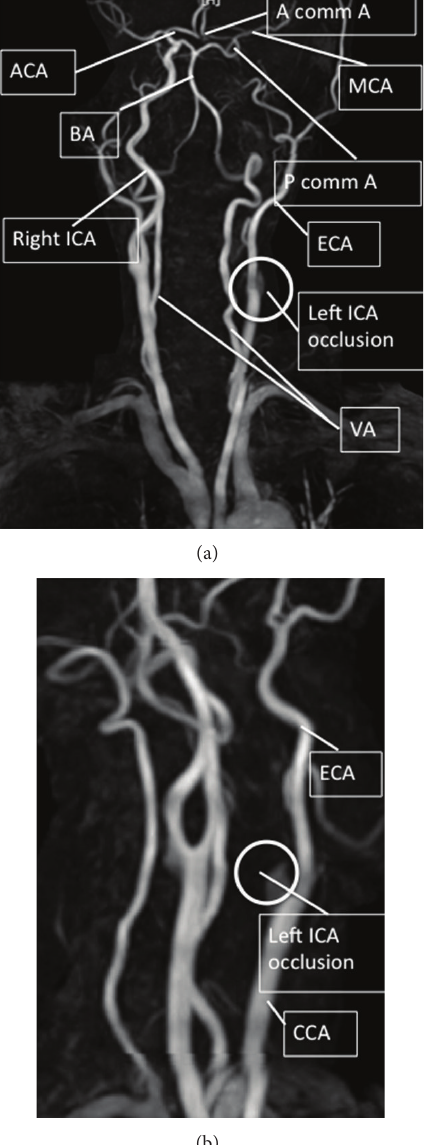
Figure 4: MRA showed an occluded carotid artery 1cm from the origin (arrows). The anterior and middle cerebral arteries were being nourished through the anterior and posterior communicating arteries. A comm A: anterior communicating artery, ACA: anterior cerebral artery, P comm A: posterior communicating artery, BA: basilar artery, CCA: common carotid artery, ICA: internal carotid artery, ECA: external carotid artery, MCA: middle cerebral artery, and VA: vertebral